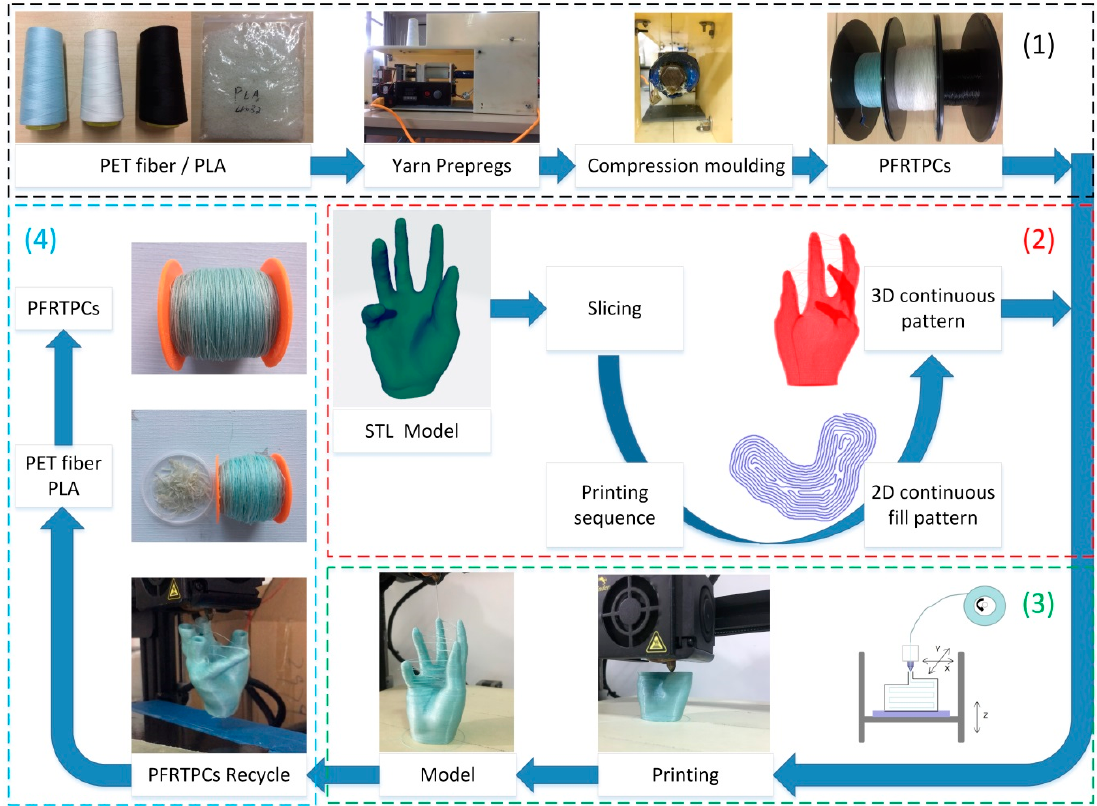
Figure 1. Continuous Polyethylene terephthalate (PET) fiber-reinforced printing framework.